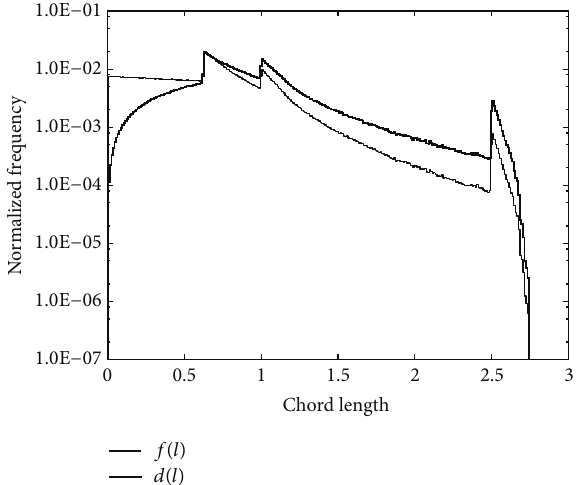
Figure 2: 𝑓(𝑙) and 𝑑(𝑙) distributions for a rectangular parallelepiped with relative dimensions 2.5 × 1 × 0.625 .